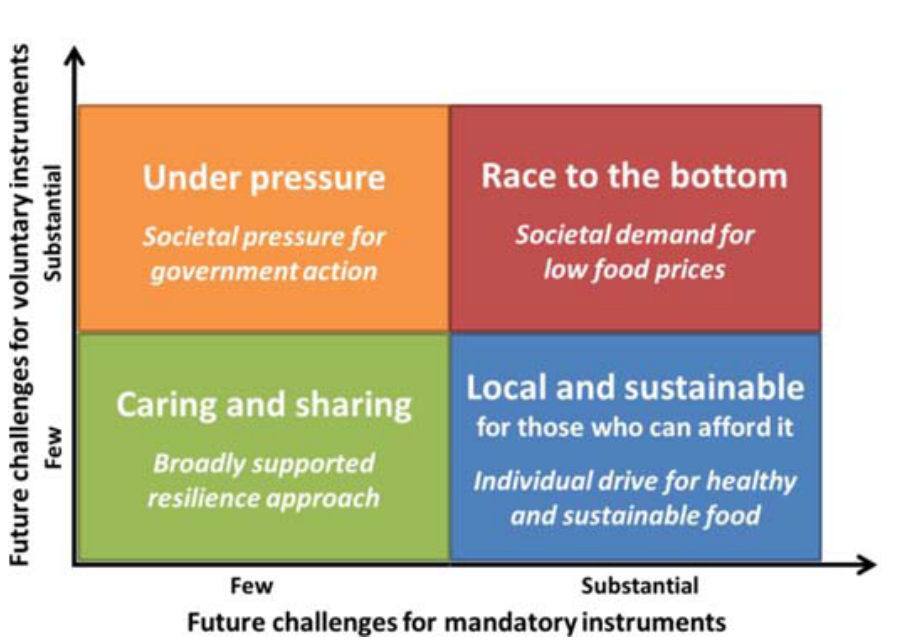
Figure 4. Overview of scenario framing linked with scenario titles and motivating factors [82].